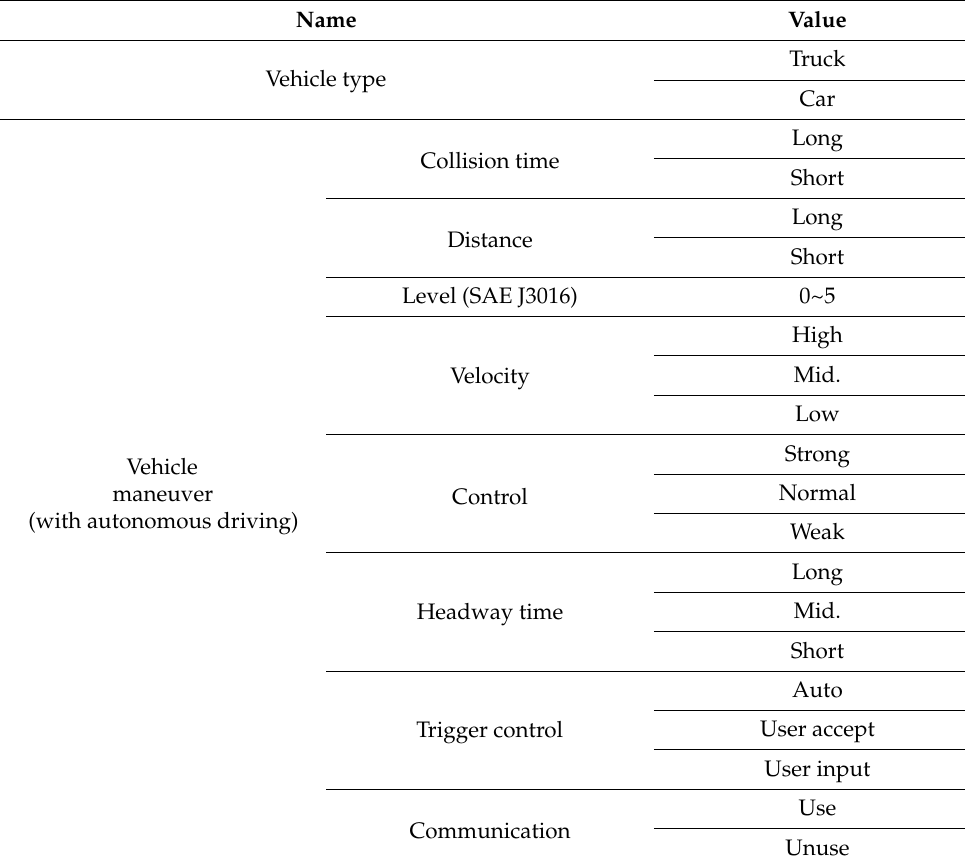
Table 2. Scenario